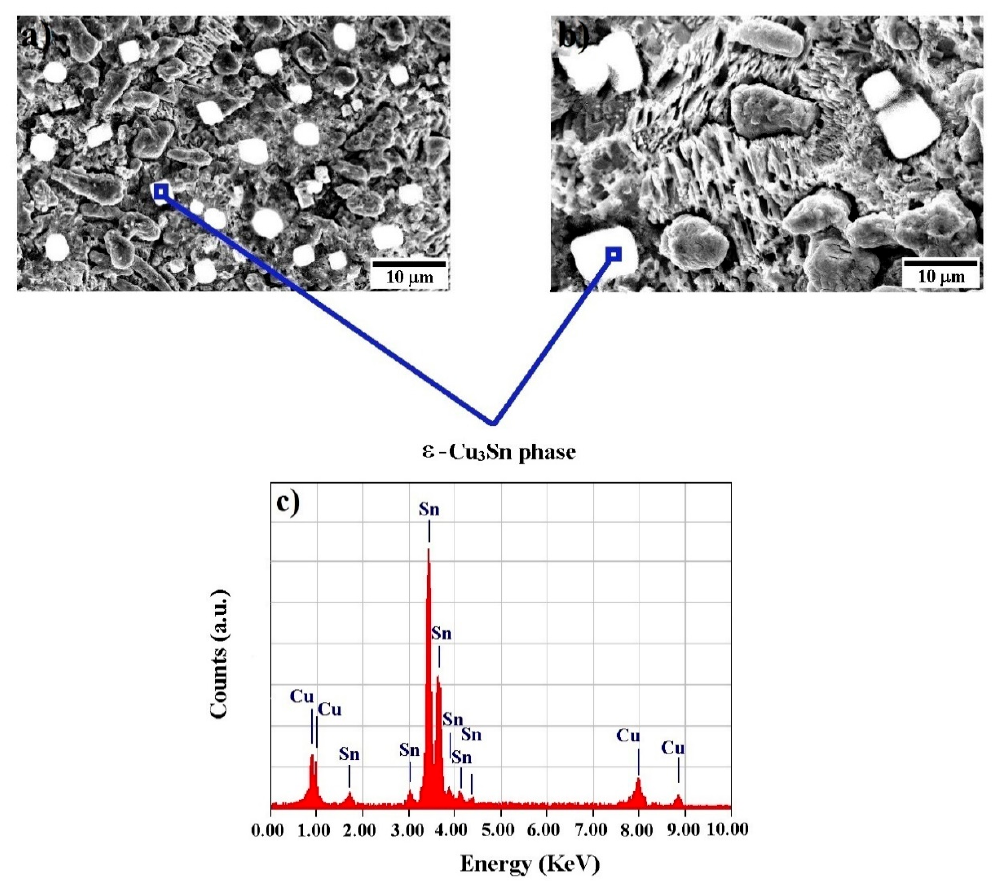
Figure 5. ( a ) SEM image of SZ-2Cu alloy aged at 323 K, ( b ) SEM image of SZ-2Cu alloy aged at 398 K, ( c ) EDS spectrum of ε -Cu 3 Sn phase.